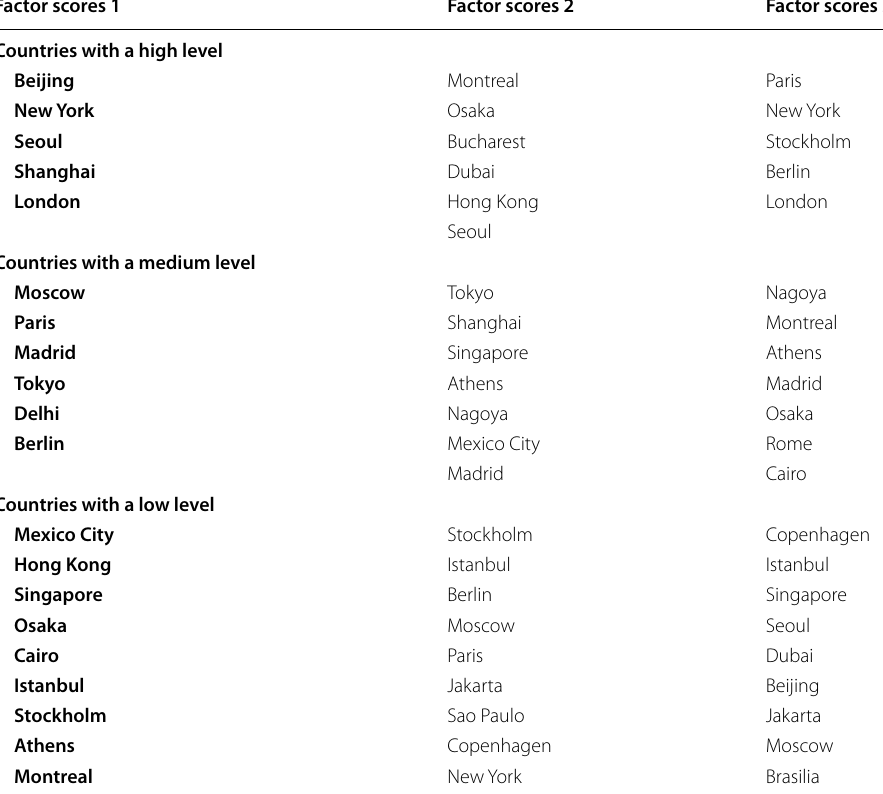
Table 6 Country classification according to factor scores Factor scores 1 Factor scores 2 Factor scores 3 Countries with a high level